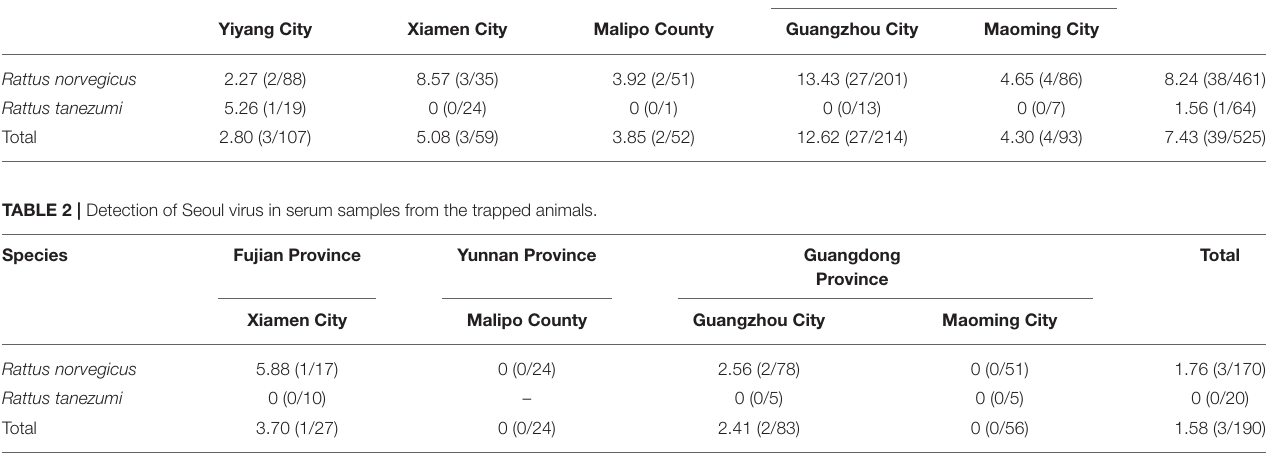
TABLE 3 | Seoul virus in the lung tissue and serum samples from animals with Seoul virus-positive liver tissue samples.